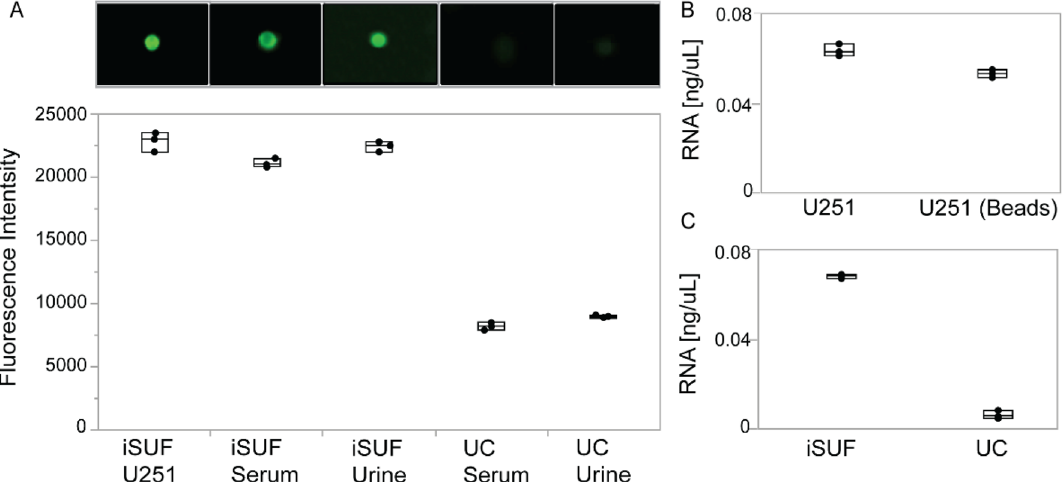
Figure 5. Characterization of stained tEVs isolated from U251-CCM and spiked in different biofluids. ( A ) Upper. Fluorescence images of tEVs on magnetic beads using TIRF microscopy. Lower. Comparison of fluorescence intensities quantified using imaging flow cytometry. Stained U251-EVs isolated by iSUF was a positive control. tEVs isolated from serum and urine samples using iSUF demonstrated no significant difference (n = 3; p > 0.05), while UC isolated tEVs differed with iSUF and the positive control (n = 3; p < 0.05) (mean ± STD). ( B ) Quantification of total RNA isolated from U251-EVs before and after bead extraction showed no differences (n = 3; p > 0.05). ( C ) Total RNA extracted from serum samples using iSUF was significantly higher than using UC (n = 3; p < 0.05) (mean ±